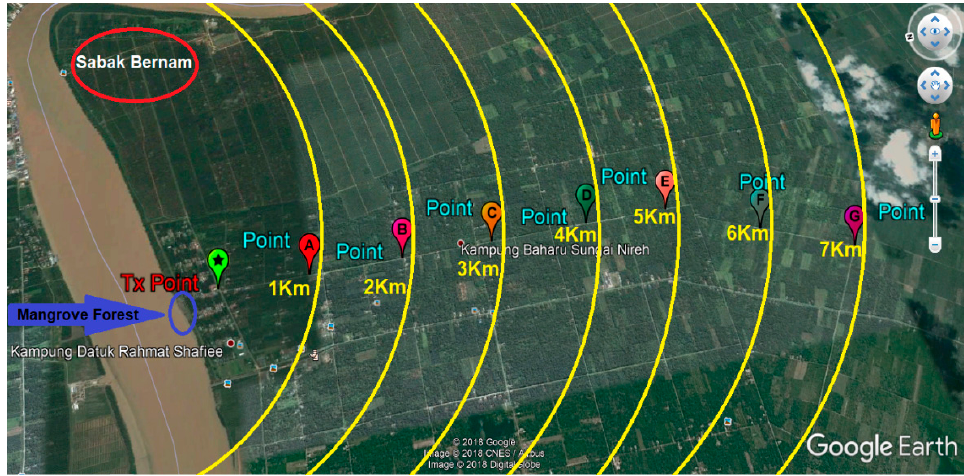
Figure 4. LoRa measurements from different locations in Sabak Bernam (Ptx = 14 dBm).